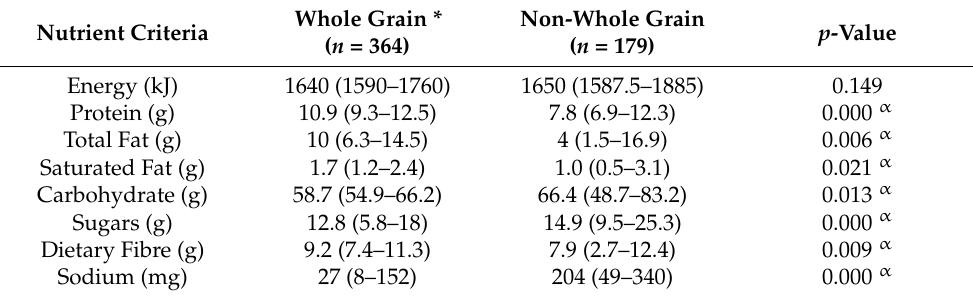
Table 6. Comparison of nutrients in whole grain and non-whole grain breakfast cereals (per 100 g) (median (IQR)) in